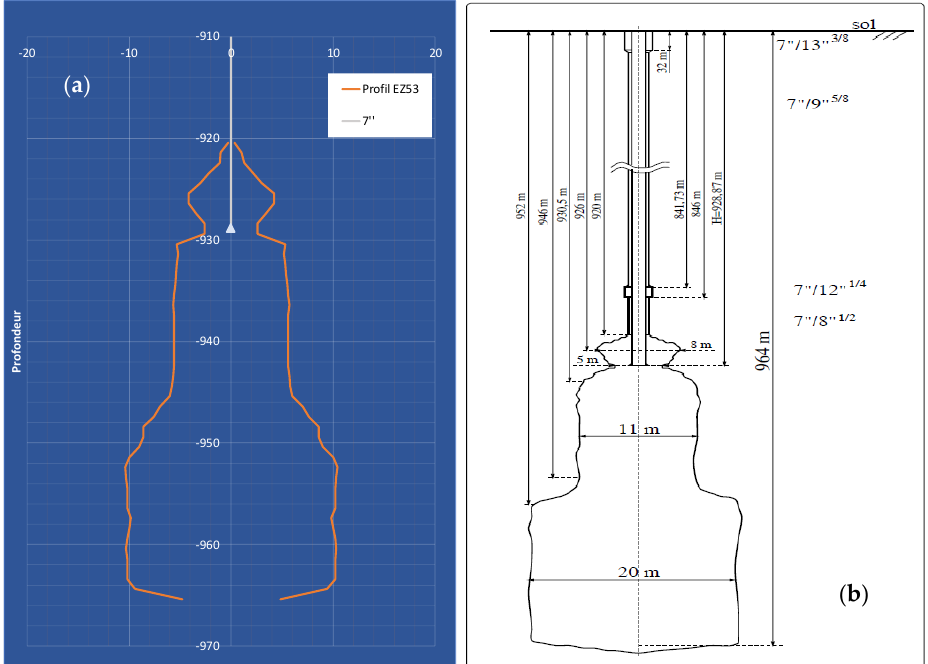
Figure 1. ( a ) Last sonar profile of the EZ53 cavern created on 23 April 1985 (source, Storengy), ( b ) characteristic depths and diameters of the well and cavern [14].